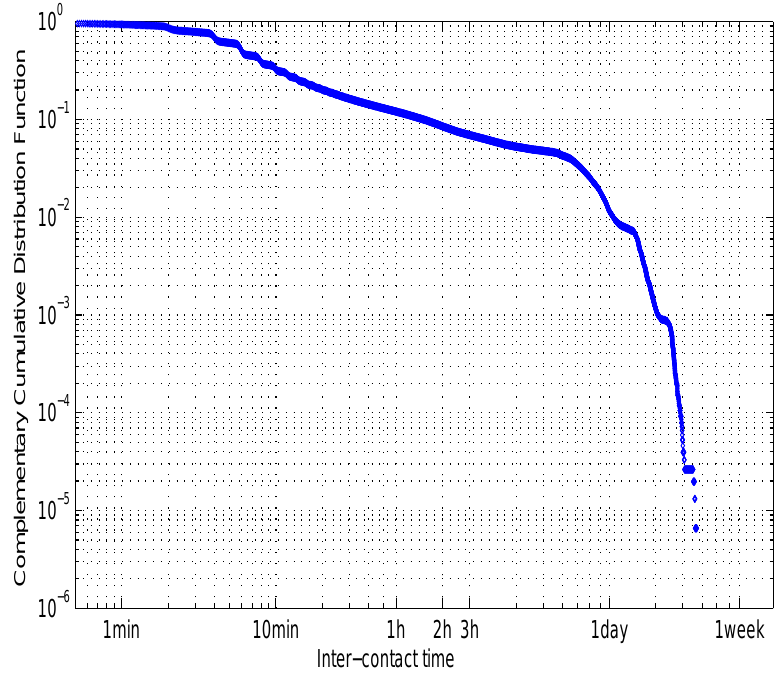
Figure 5. The Complementary Cumulative Distribution Function (CCDF) of inter-contact time in the Infocom6